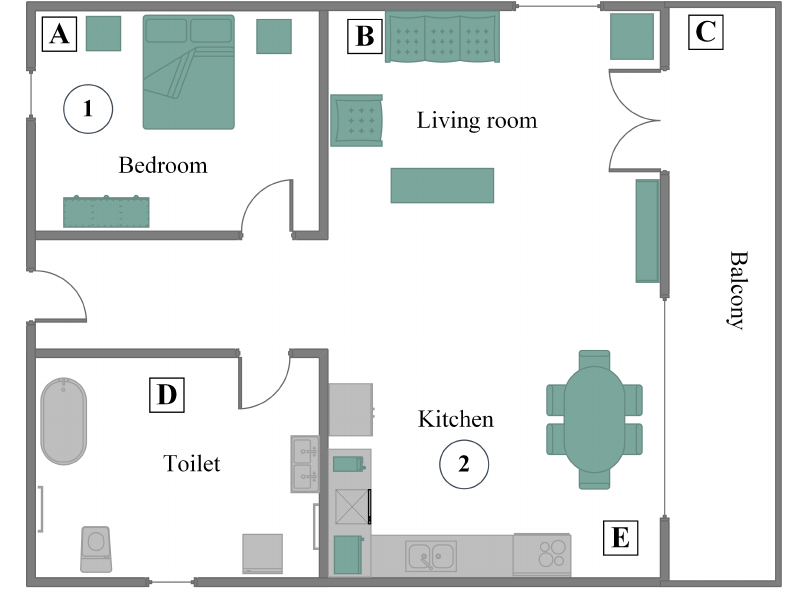
Figure 1. A typical household for a dementia